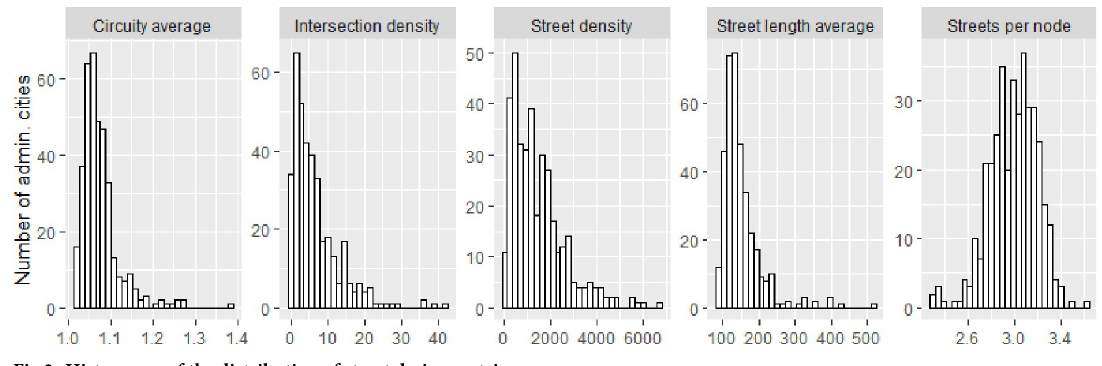
Fig 2. Histograms of the distribution of street design